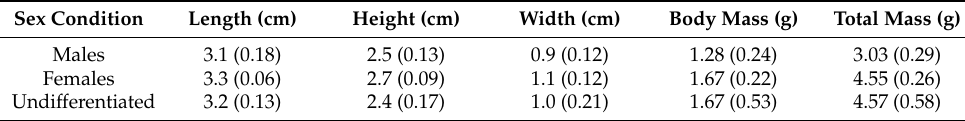
Table 1. Body morphometry of S. plana used in the study.